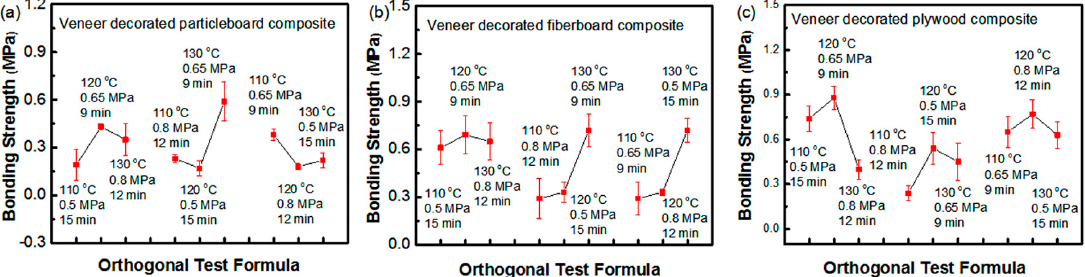
Figure Figure 2. Optimization of the hot pressing conditions of the three kinds of composites: ( a ) The veneer- decorated particleboard composite; ( b ) the veneer-decorated fiberboard composite; and ( c ) the veneer-decorated plywood composite.